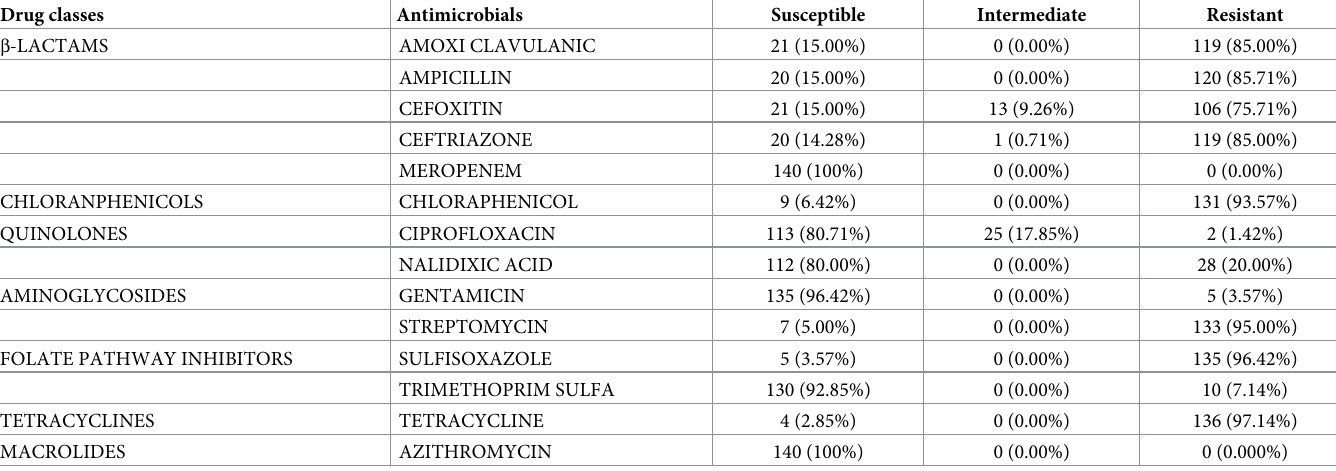
Table 1. Antimicrobial resistance proportions of the 140 Salmonella Dublin isolates in cattle from the United States. Drug classes Antimicrobials Susceptible Intermediate